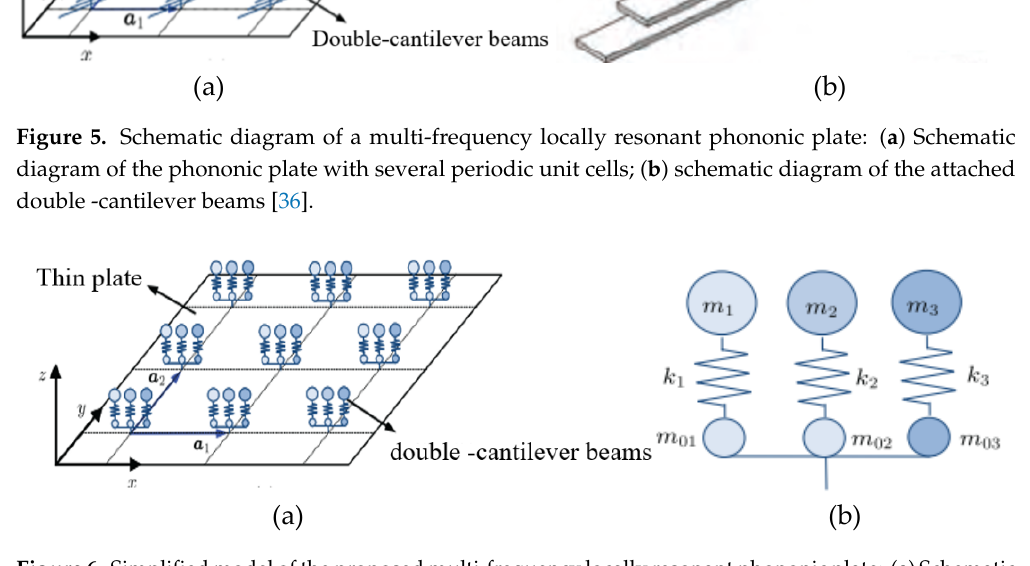
Figure 6. Simplified model of the proposed multi-frequency locally resonant phononic plate: ( a ) Schematic diagram of the simplified model with several periodic unit cells; ( b ) The low-frequency equivalent “mass-spring-mass” system of the attached double-cantilever beams [36].